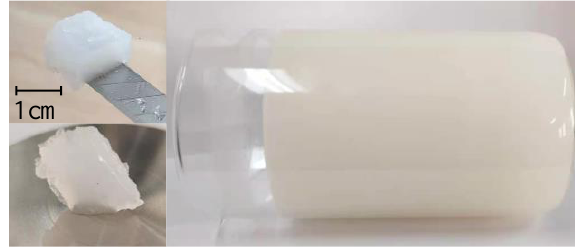
Figure A1. Example of the gelled fuel.